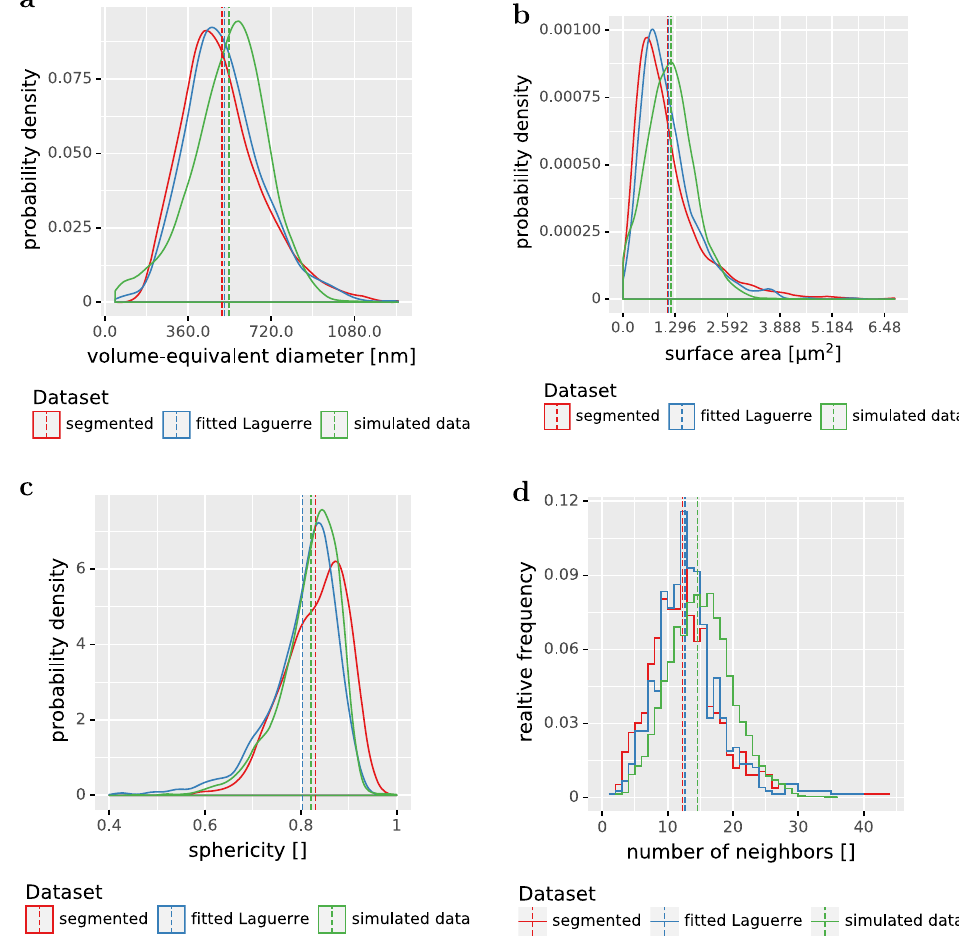
Fig. 9 Validation of the grain architecture model. Grain-based characteristics of the segmented FIB-EBSD image data, the fi tted Laguerre tessellation and of a realization of the stochastic grain architecture model. Estimated probability densities and mean values (dashed vertical lines) of the volume-equivalent diameter ( a ), surface area ( b ), and sphericity ( c ); and histograms of the number of grain neighbors ( d